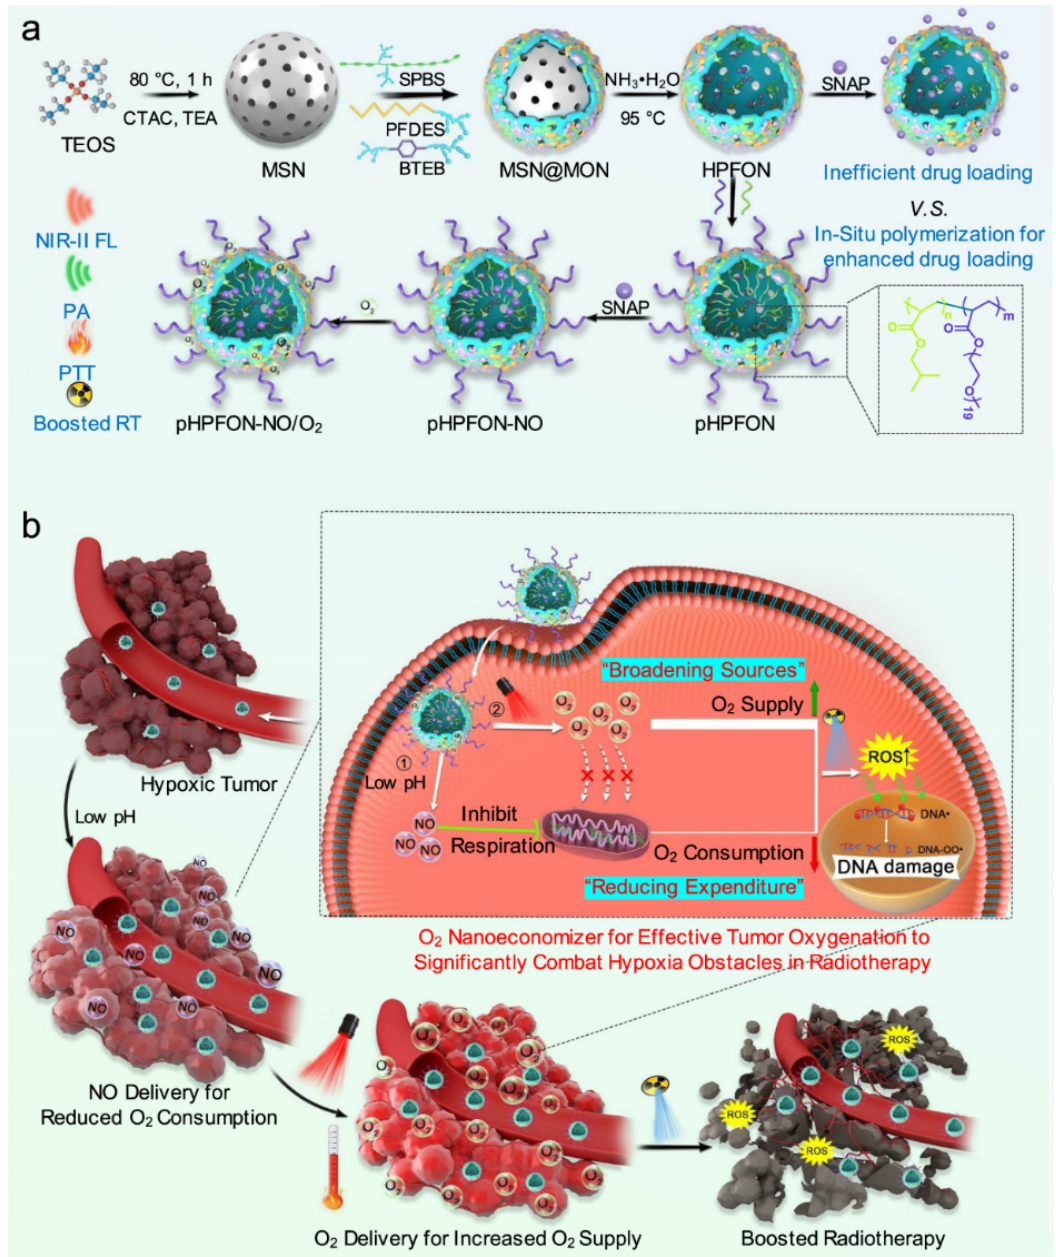
Figure 9. ( a ) Synthetic procedures. First, sub-50 nm SP brush/fluorocarbon/phenylene triple-hybridized HPFON